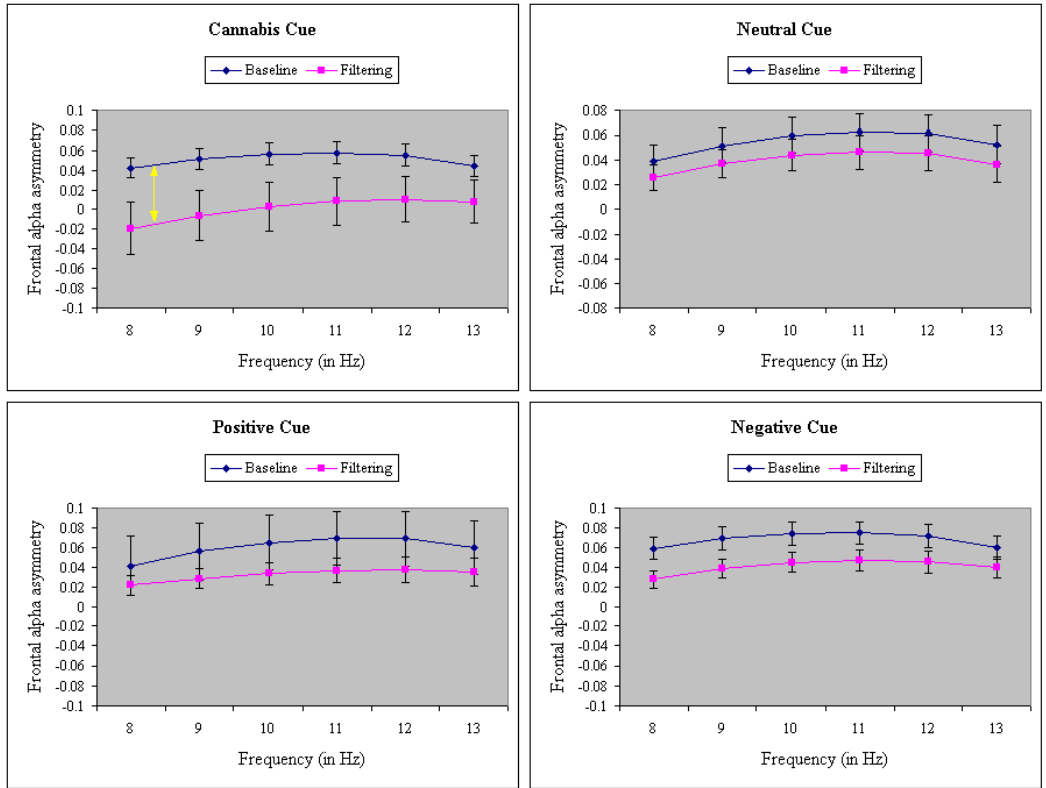
Figure 2. A significant three-way interaction of task (baseline vs. filtering), cue (cannabis, neutral, positive, and negative) and frequency (8–13 Hz) on frontal alpha asymmetry. Larger task difference at low alpha was especially prominent to cannabis cues relative to neutral, positive, and negative cues. Error bars represent the standard error of the mean.